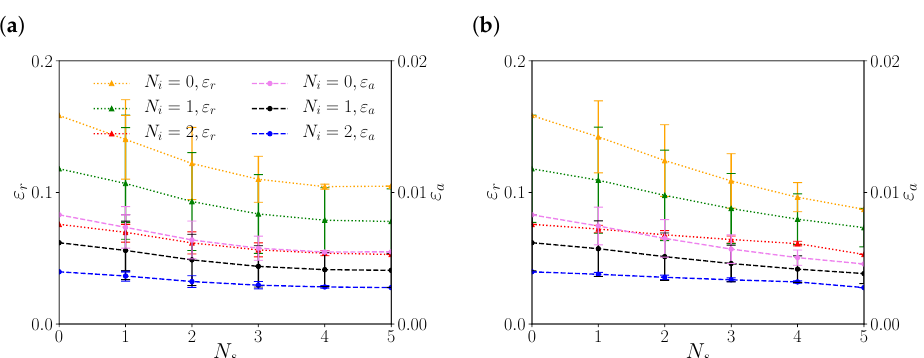
Figure A8. As in Figure 12, but for the heterogeneous neighbourhood and an easterly wind. ( a ) u x ; ( b ) u y . N i = 0, ε r are represented by yellow dotted lines; N i = 0, ε a are represented by pink dashed lines; N i = 1, ε r are represented by greed dotted lines; N i = 1, ε a are represented by black dashed lines; N i = 2, ε r are represented by red dotted lines; N i = 2, ε a are represented by blue dashed lines;